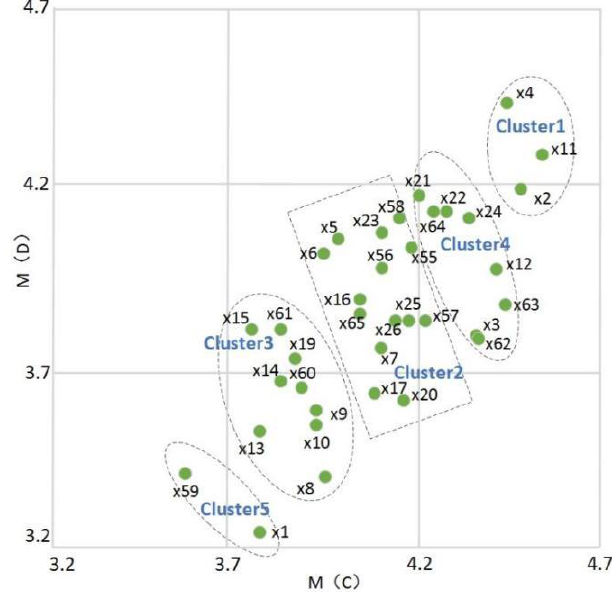
Figure 3. Clusters of social-technical sustainability indicators